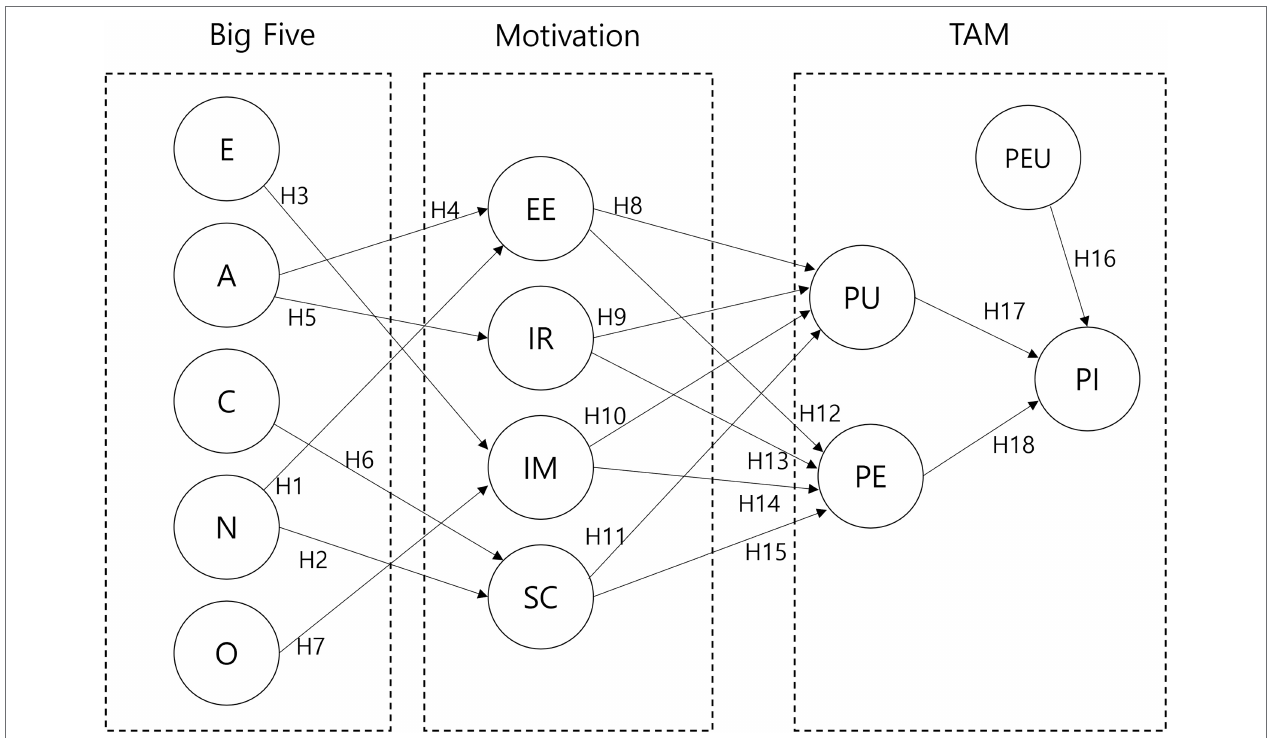
FIGURE 2 | Research